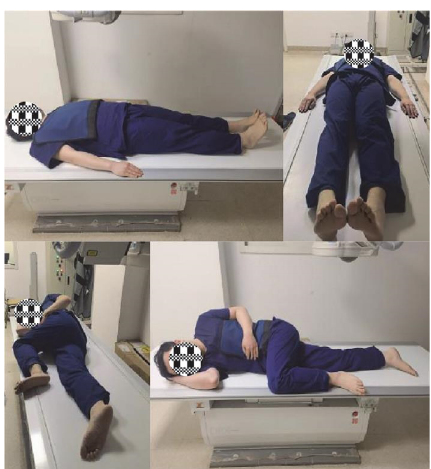
F IGURE 2: Position of the patient in radiology after